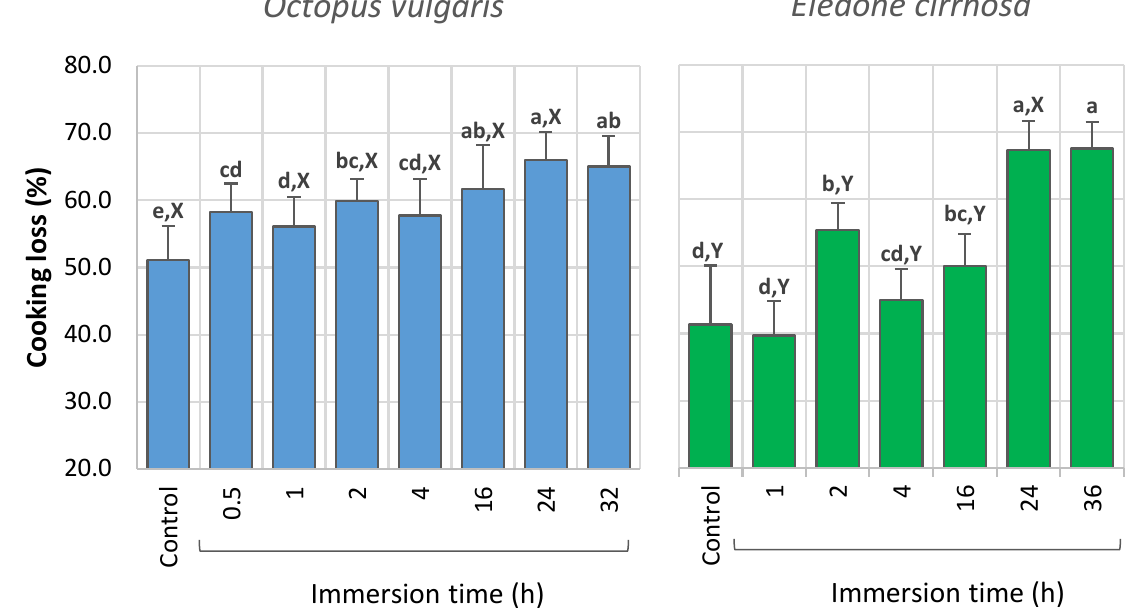
Figure 3. Cooking loss (%) of Octopus vulgaris and Eledone cirrhosa water-added samples immersed in freshwater for 0.5 h to 36 h. Different letters denote significant differences between species (X, Y) and different immersion time periods (a, b, c, …) for each species.